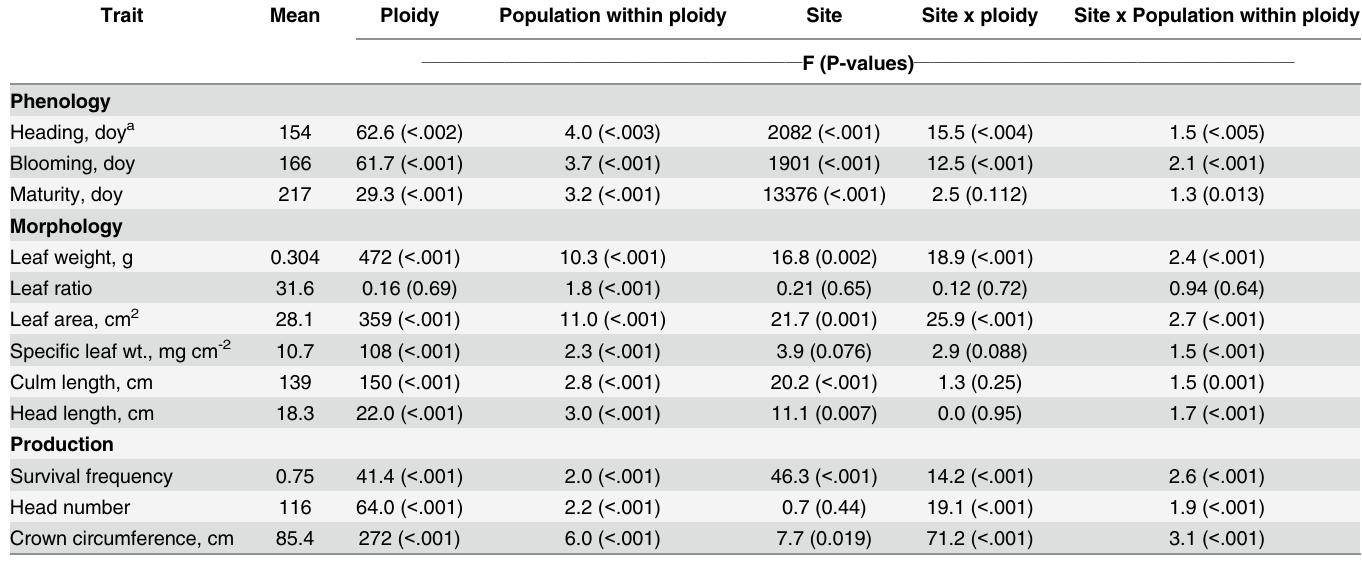
Table 2. Summary of analyses for 109 basin wildrye source populations growing in common gardens at Central Ferry and Pullman, WA in 2012 and